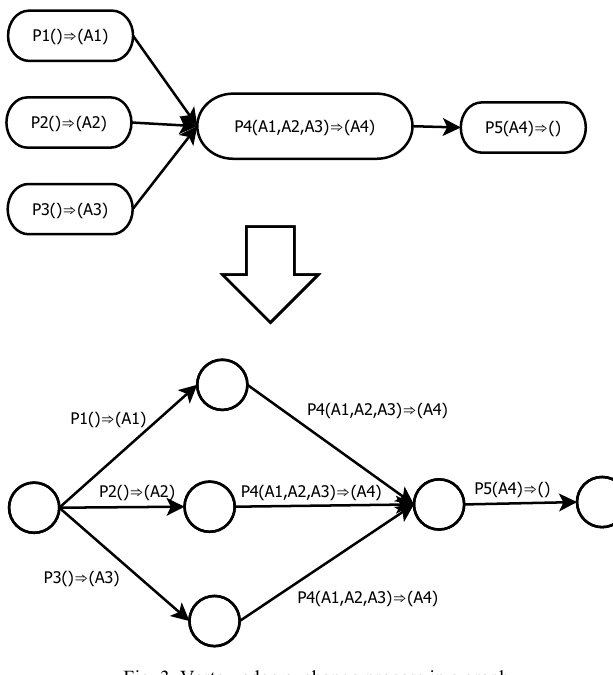
Fig. 3. Vertex-edge exchange process in a graph.